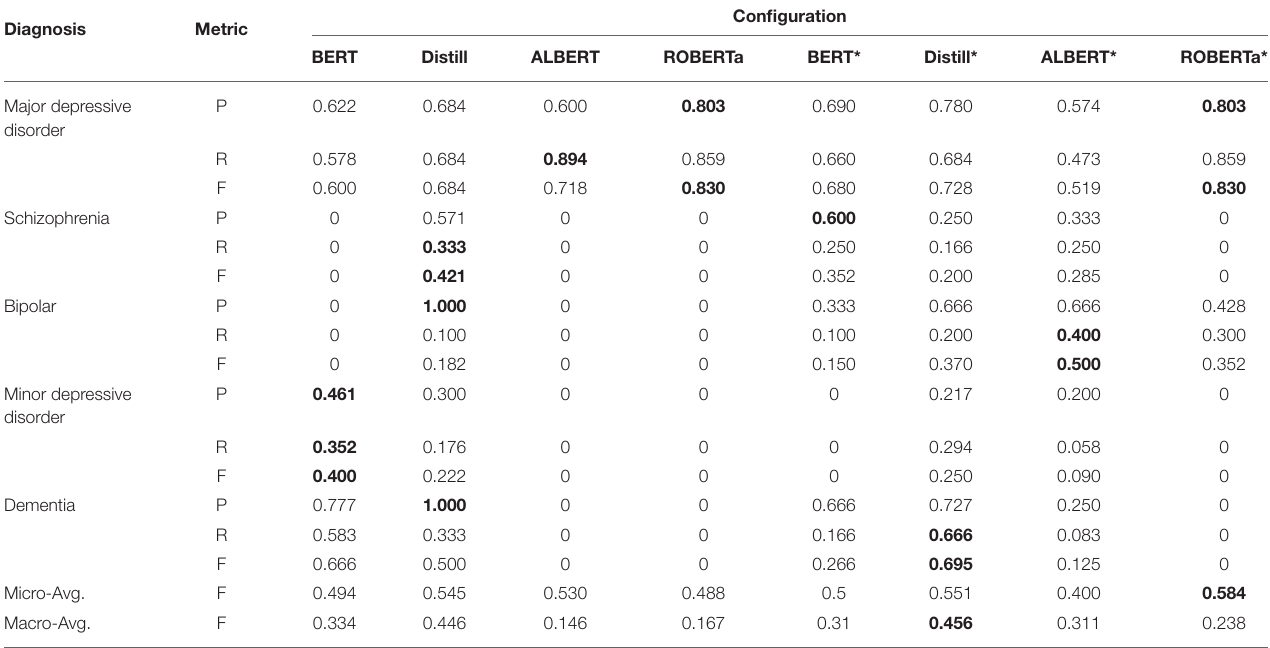
TABLE 1 | Performance of the BERT-based models with problem transformation on the test set.